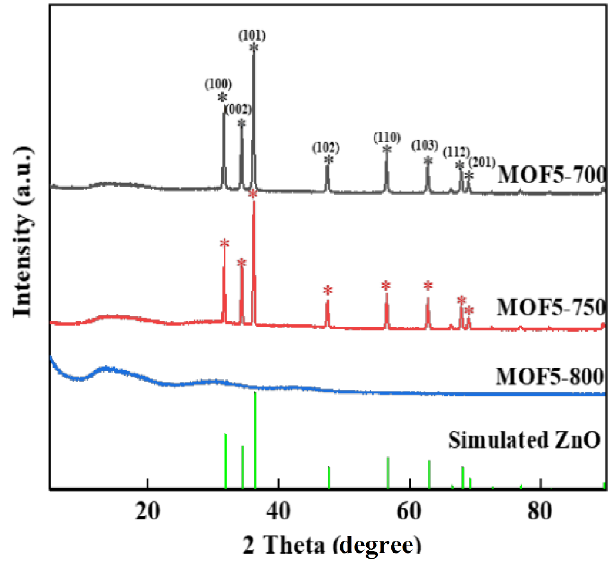
Figure 12. Adsorption/desorption isotherms, pore size distribution of pore volume ( a ) and distribution of mesopores to total pore volume ( b ) for MOF5-700, MOF5-750 and MOF5-800. All the samples were collected and measured with XRD, and the results are presented in Figure 13. The calcined sample showed the characteristic diffraction peaks of ZnO. The MOFs samples (MOF5-700 and MOF5-750) under the pyrolysis conditions of 700 °C and 750 °C can be observed to have obvious diffraction peaks at 31°, 34°, 36°, 47°, 56°, 62°, and 67°. This corresponds to the reflection of (100), (002), (102), (110), (103), and (112) crystal planes of the ZnO standard diffraction peak (JCPDS No. 41-1487). The results show that the zinc in the MOF5-700 and MOF5-750 samples is mainly in the form of ZnO. The results of XRD characterization showed that compared with the diffraction peaks of MOF5-700 and MOF5-750, MOF5-800 did not observe the obvious characteristic diffraction peaks of ZnO, and two diffraction peaks at 24.41° and 43.71° were amorphous peaks, which were consistent with the (002) and (101) crystal planes of AC [34]. It shows that a large amount of zinc element is lost after the sample is calcined at high temperature [35]. In addition, only a very small amount of Zn content was detected by testing the MOF5-800 sample. For example, according to the ICP test, the Zn content in MOF5-800 was only 0.6%, and the result measured by XPS was 0.38%. Both measurement results can prove that MOF5-800 has a very low Zn content compared with the other two samples.